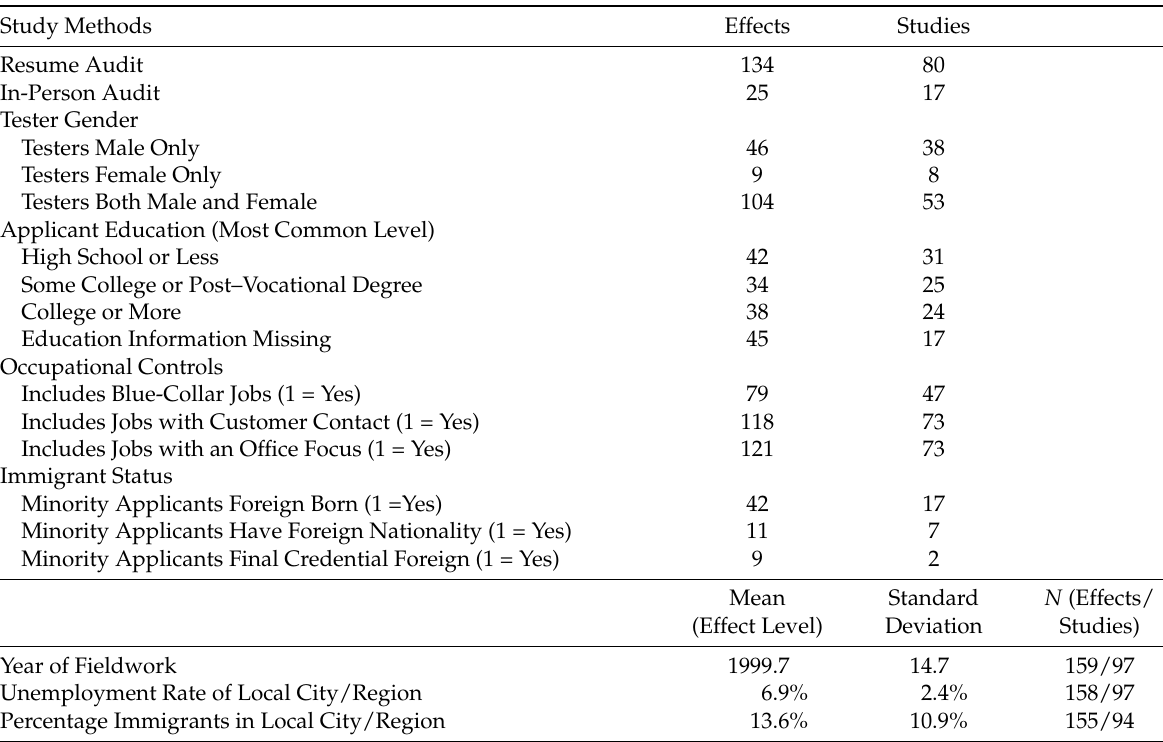
Table 2: Descriptive statistics, predictor